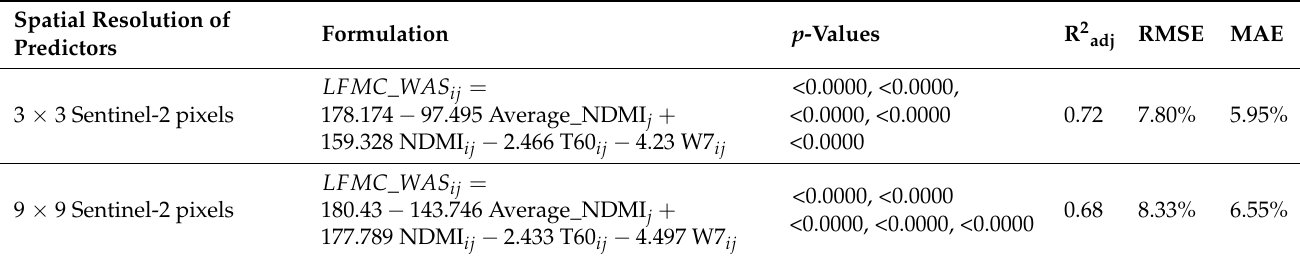
Table A2. Multiple regression models for LFMC_WAS with two spatial resolutions of predictors. The columns represent: spatial resolution of predictors, formulation, p -values of each coefficient, adjusted R 2 (R 2 adj ), root mean square error (RMSE), and mean absolute error